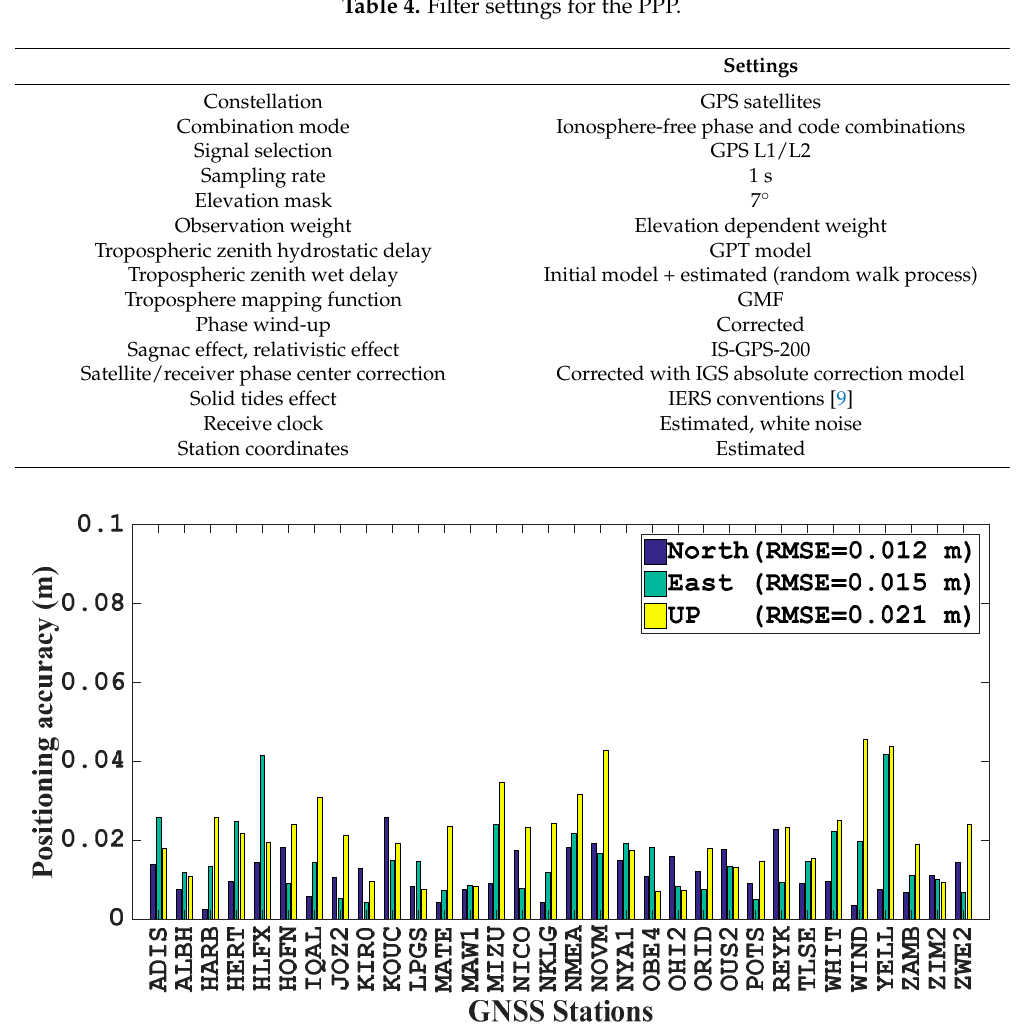
Figure 8. Positioning accuracy of 32 globally distributed IGS stations on 18 April 2017 with the predicted GPS orbit.